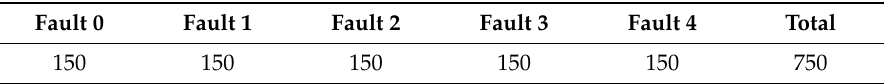
Table 2. Dataset considered for evaluation.